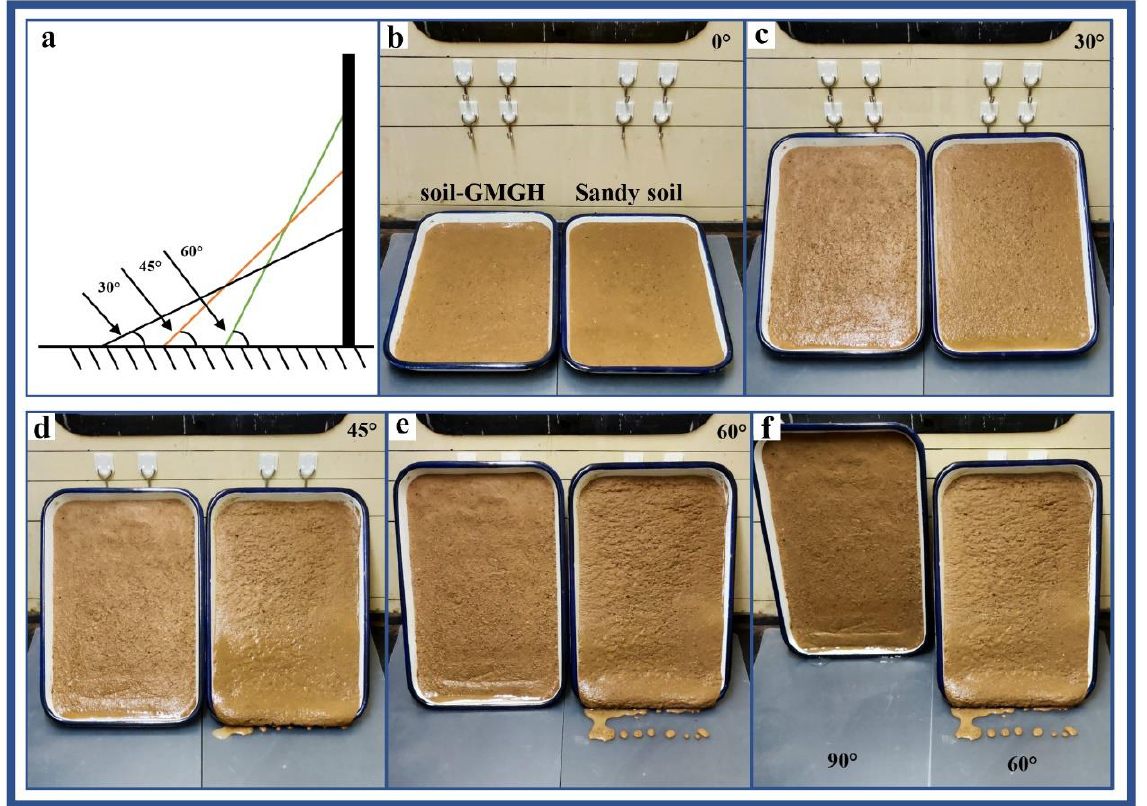
Figure 6. Sandy slope simulation diagram. ( a ) Cross-section angle; ( b ) wet soil–GMGH and sandy soil at 0 ◦ ; ( c ) wet soil–GMGH and sandy soil at 30 ◦ ; ( d ) wet soil–GMGH and sandy soil at 45 ◦ ; ( e ) wet soil–GMGH and sandy soil: 60 ◦ ; ( f ) wet soil–GMGH and sandy soil at 90 ◦ and 60 ◦